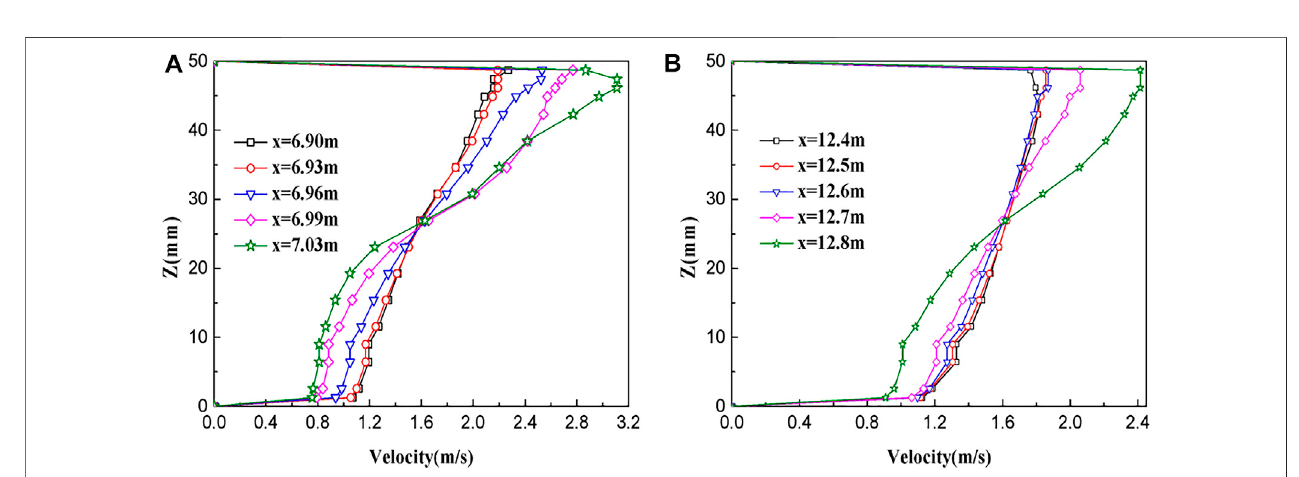
FIGURE 17 | Velocity distribution curve of (A) developing and (B) developed slugs ( V sg (cid:2) 2 m/s, V sl (cid:2) 1 m/s).